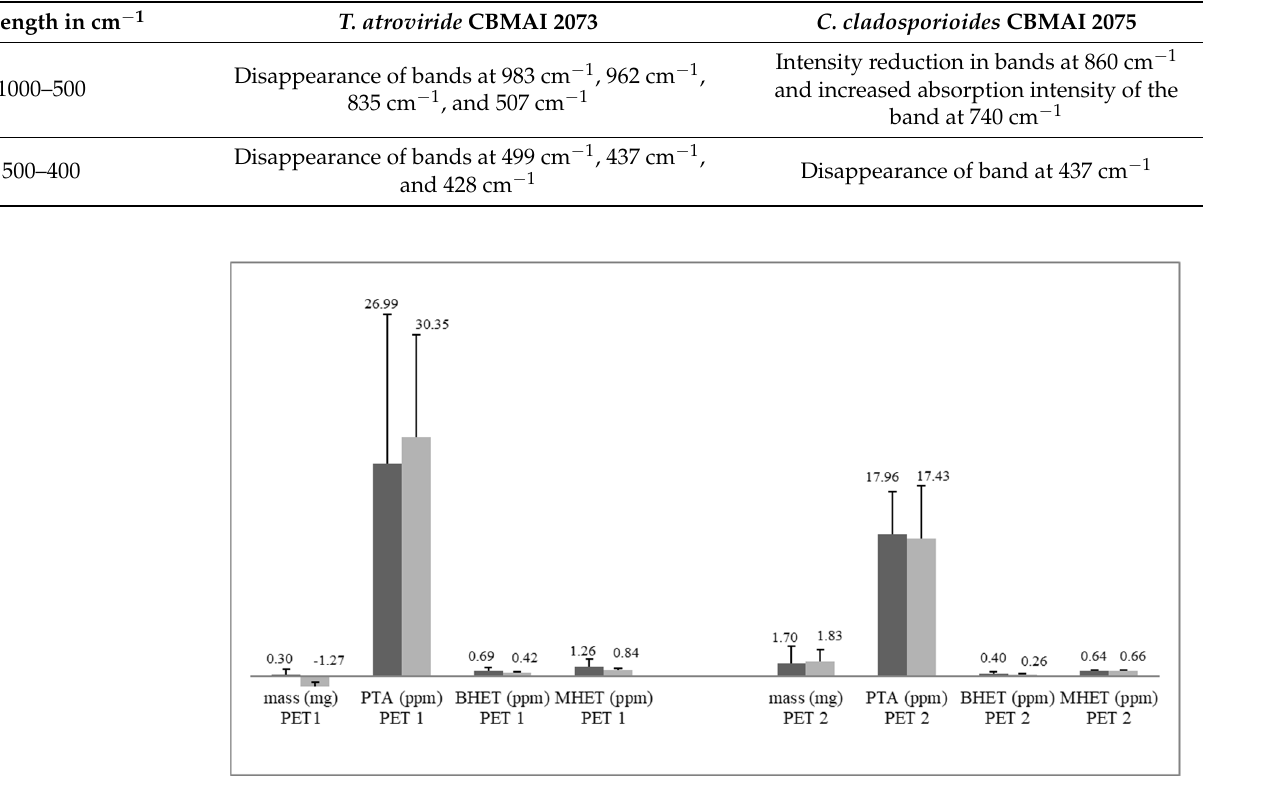
Figure 9. Mass variation (mg) and PTA, BHET, and MHET concentrations released in the fermented broth of C. trifolii (CBMAI 2111) (color dark grey) and T. sp. (CBMAI 2071) (color light grey). Fermentation time = 15 days, t = 28 °C, and 150 rpm. (Data expressed as mean + standard deviation, n = 3. Values below the x -axis indicate the mass gain of the fragment).